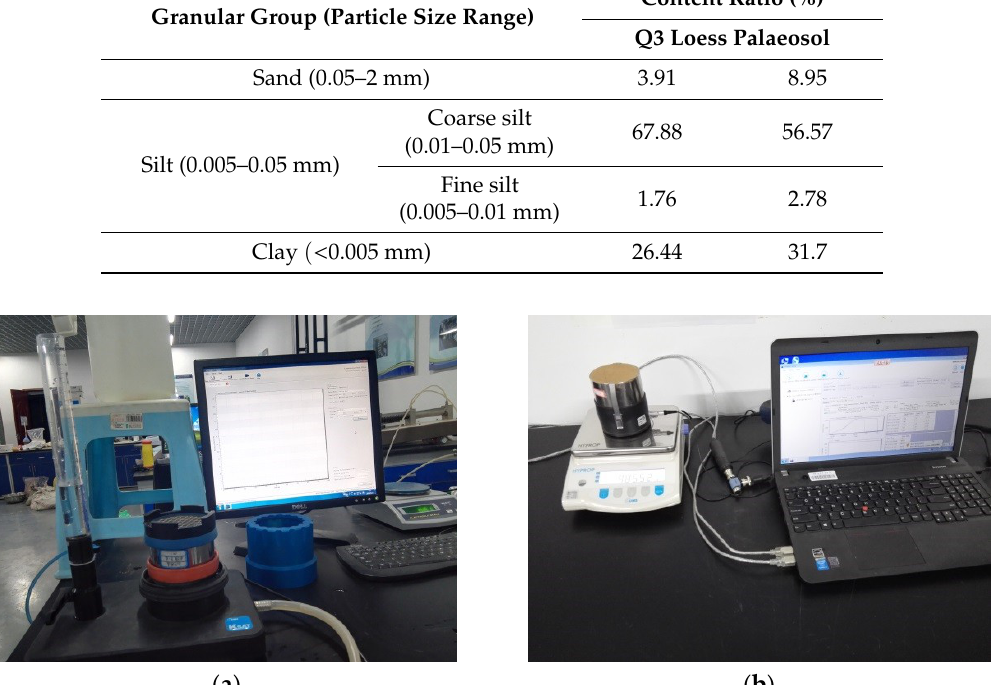
Table 1. Grain size distribution. Figure 4. Diagram of the laboratory soil column infiltration experiment.